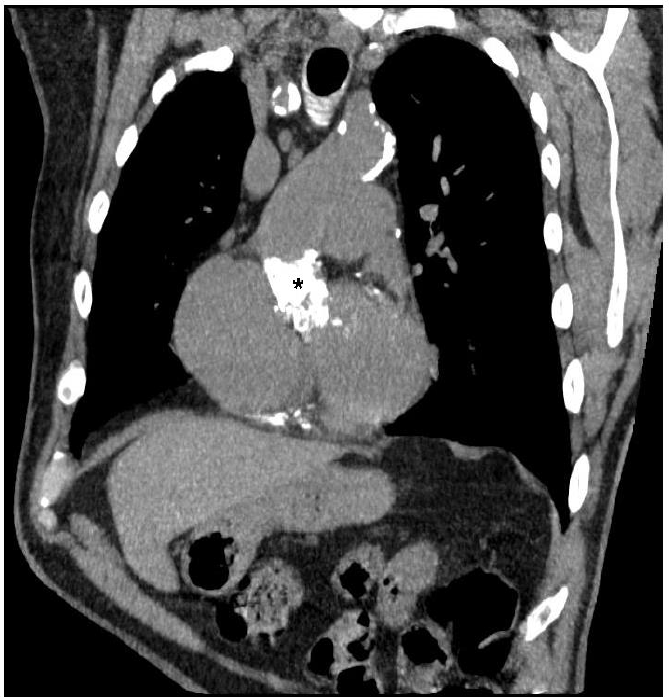
Figure 1. Preoperative computed tomography scan of a 79-year-old man who had undergone a modified Bentall procedure using a 27 mm Prima Plus stentless bioprosthesis, showing the extensively calcified porcine aortic root (*) after 11 years. The porcine aortic valve was replaced with a Perceval M sutureless bioprosthesis.